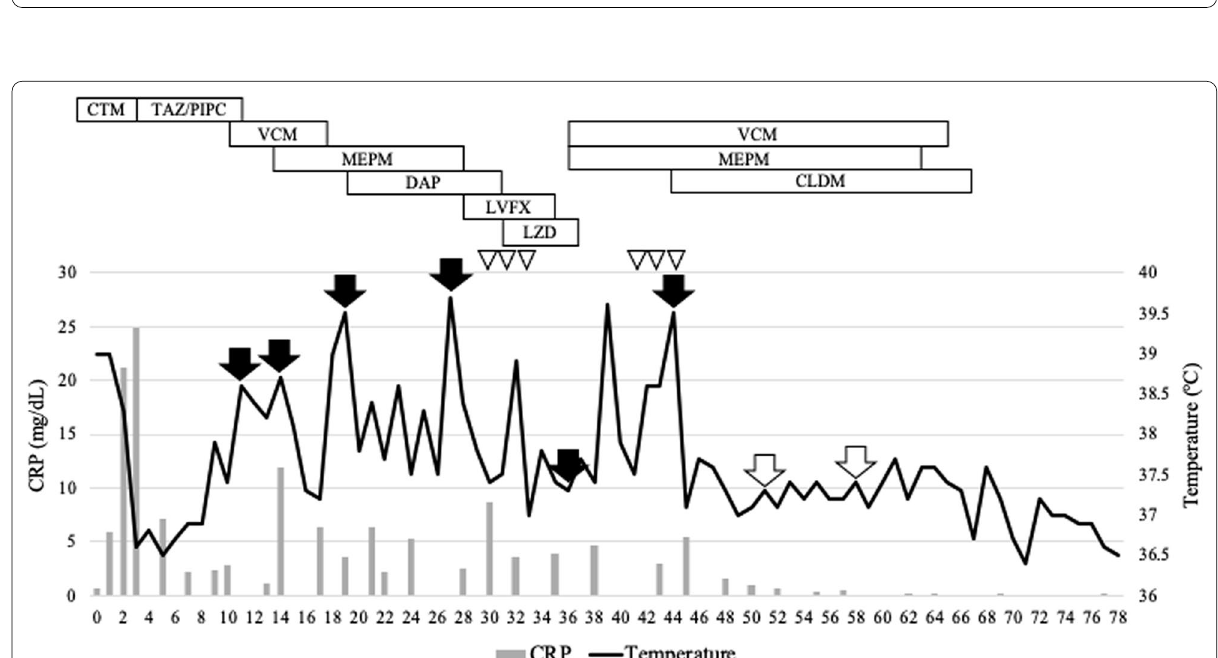
Fig. 6 The postoperative course and antibiotic treatments. The black arrow indicates S. hominis -positive blood culture, while the white arrow indicates S. hominis -negative blood culture. The white arrowhead indicates the timing of intravenous immunoglobulin administration. CTM cefotiam hydrochloride, TAZ/PIPC tazobactam, piperacillin hydrate, VCM vancomycin hydrochloride, MEPM meropenem hydrate, DAP